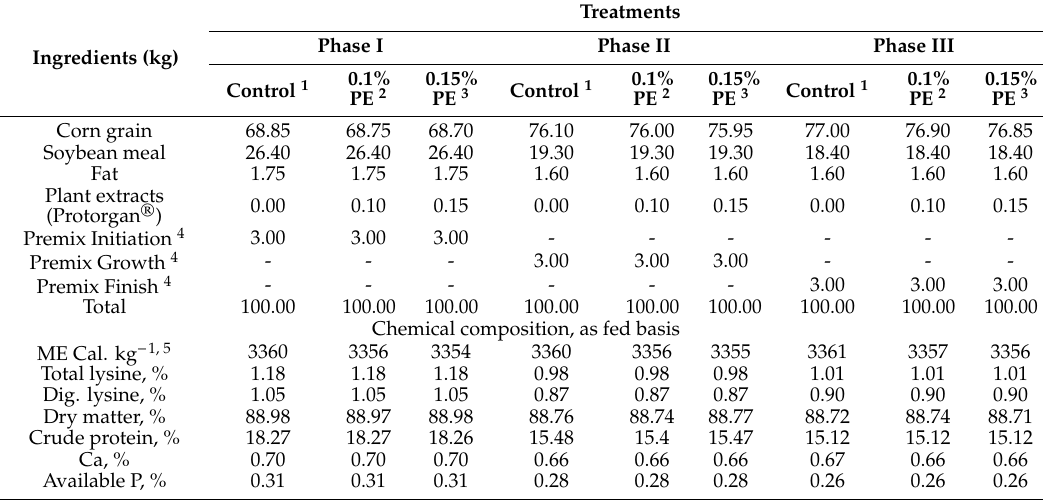
Table 1. Composition of experimental diets for pigs in growing-finishing